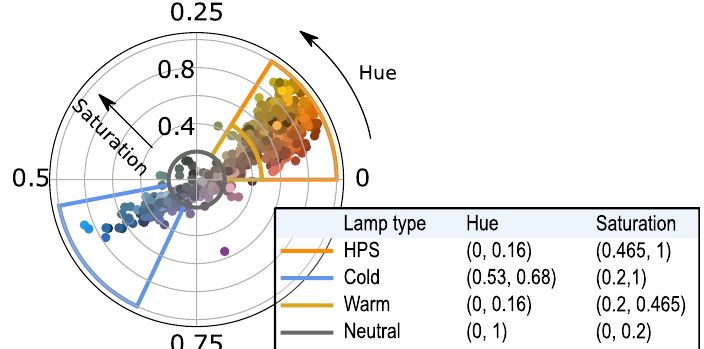
Figure 6. Scatter plot of the whole NightUp database as a function of saturation (distance from the centre) and hue (angle). The coloured lines separate the regions of the H-S pace corresponding to different blue-light intensity levels. The boundaries of these regions are indicated in the